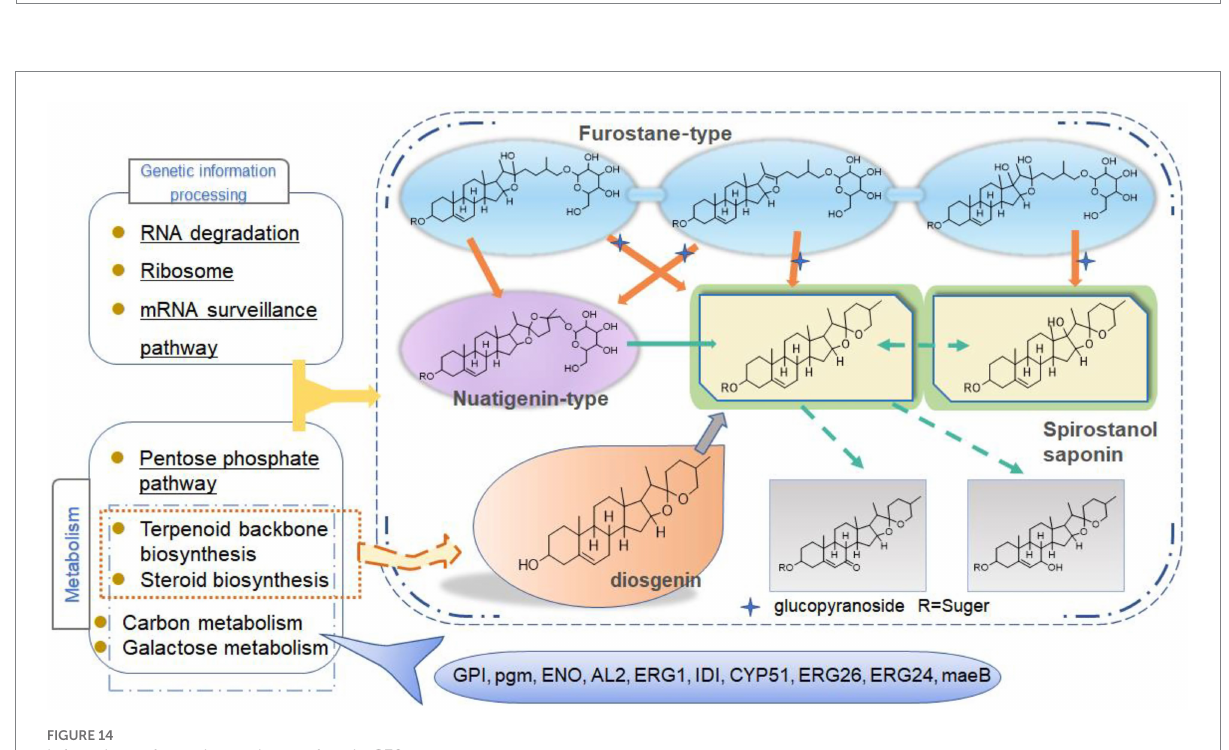
FIGURE 14 Inferred transformation pathway of strain C39.